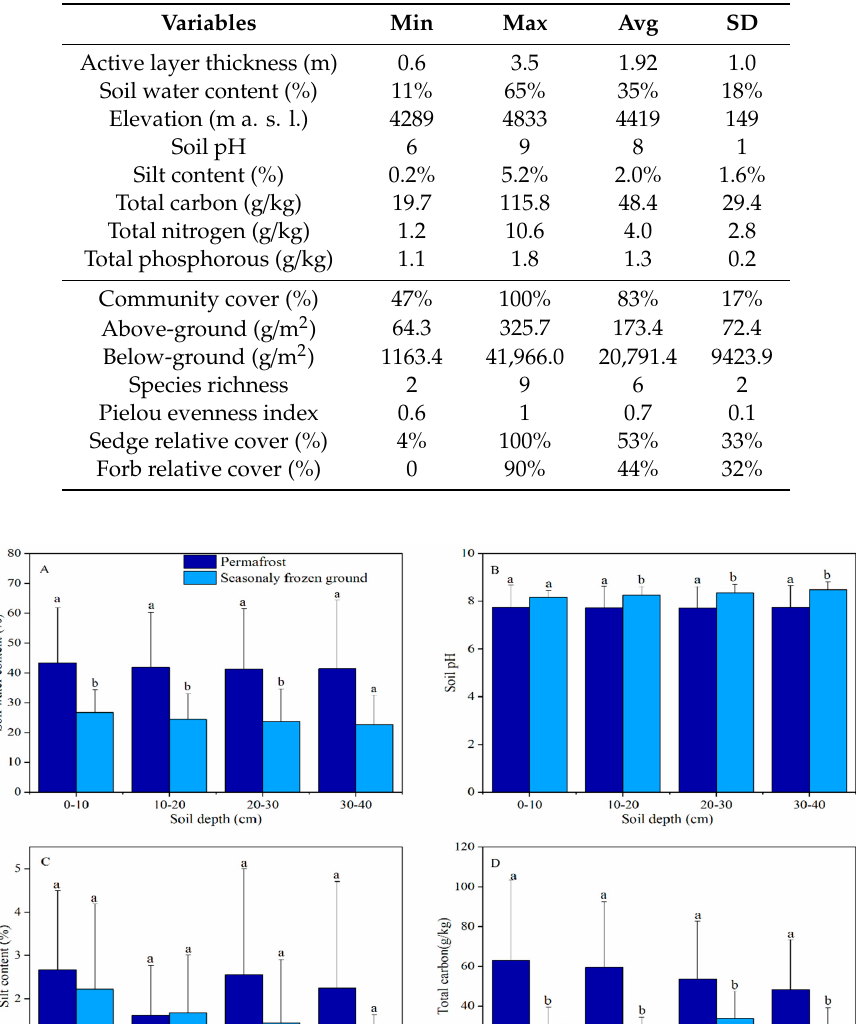
Table 2. Soil environment and characteristics of vegetation at permafrost sites in the headwater area of the Yellow River on the northeastern Qinghai-Tibet Plateau, Southwest China. N = 13. Data at di ff erent depths were averaged for the site level.